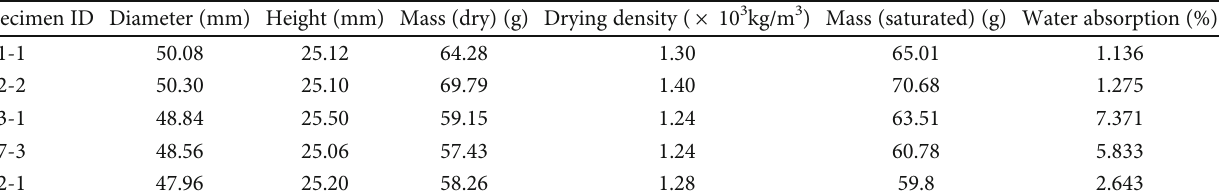
Table 2: Changes in parameters before and after saturation of coal samples.